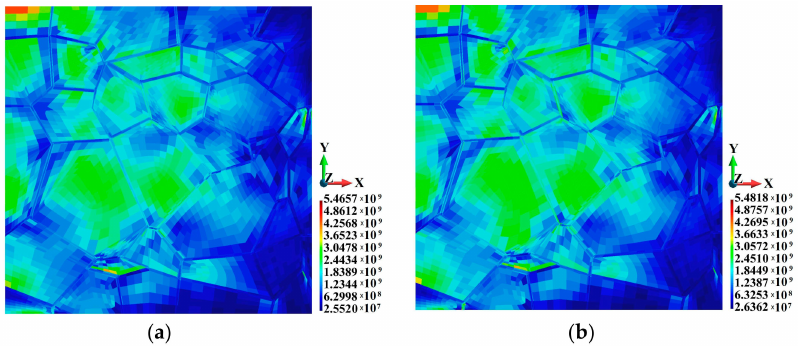
Figure 6. Huber-Mises-Hencky stress (Pa): ( a ) Adiabatic solution; ( b ) coupled